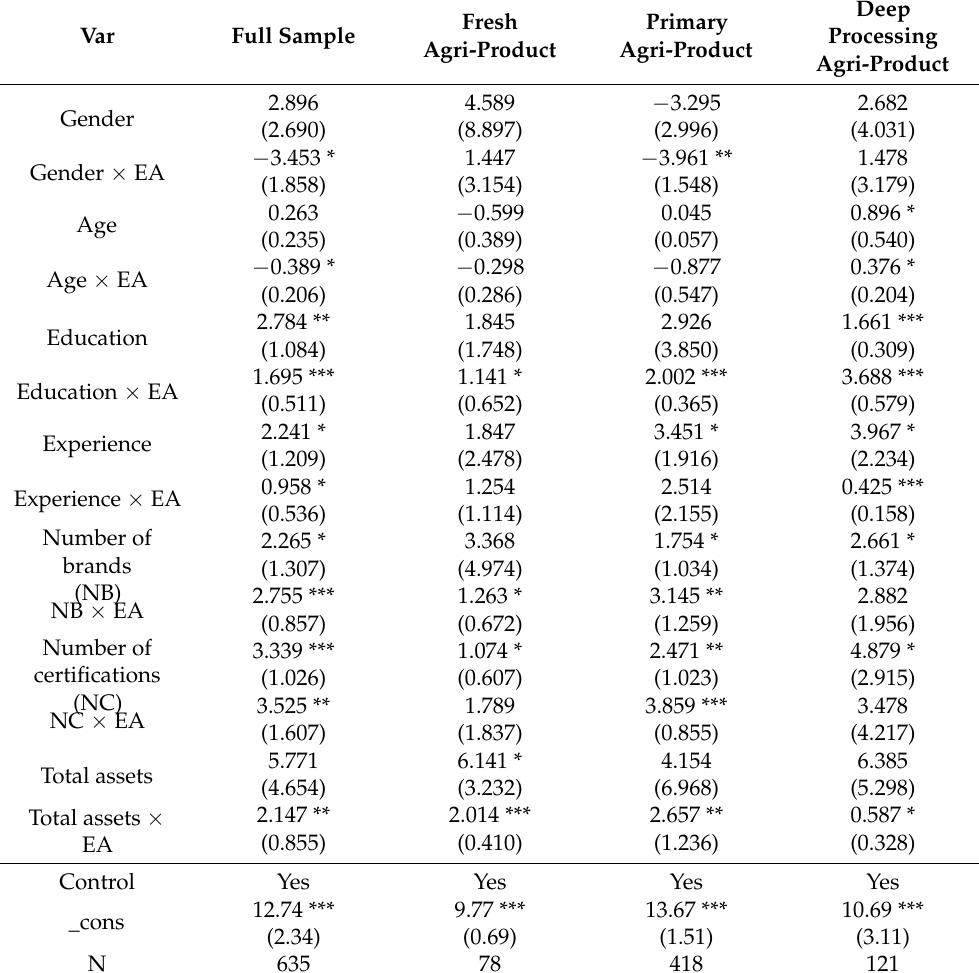
Table 7. Factors influencing the effect of